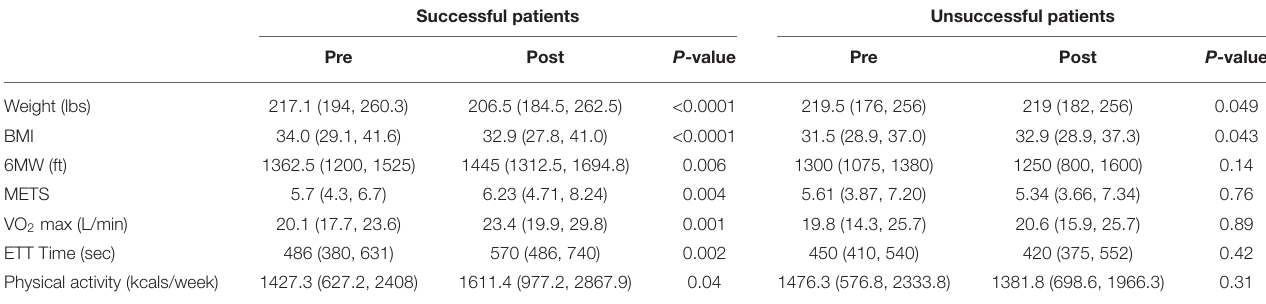
TABLE 2 | Changes in weight loss, physical fitness, and physical activity pre- and post-intervention. Successful patients Unsuccessful patients Pre Post P -value Pre Post P